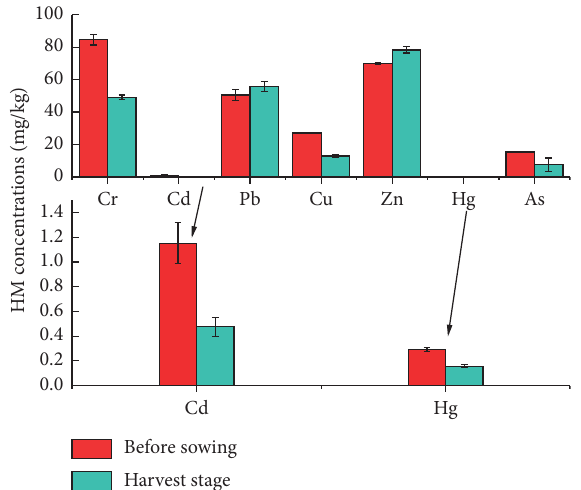
Figure 2: Concentration of heavy metals in soil at the different growth periods of rice.